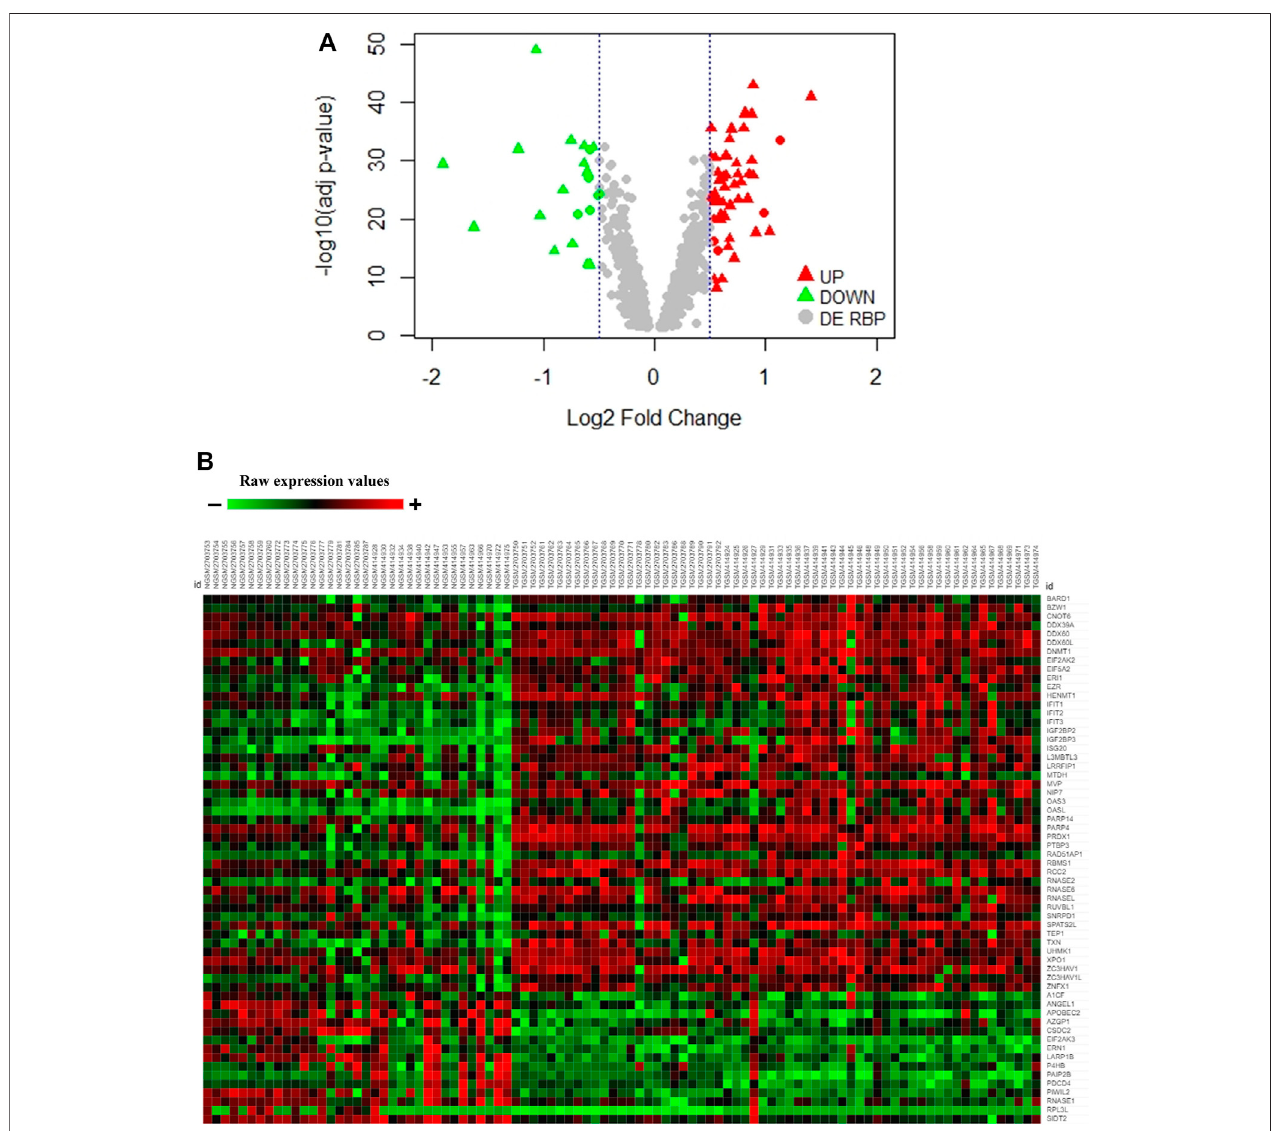
FIGURE 1 | Expression pattern of DE-RBPs in pancreatic cancer. (A) Volcano plot showing signi fi cant DE-RBPs in the discovery dataset where red and green trianglesdenotevalidatedupregulatedanddownregulatedRBPs,respectively. (B) Heatmapof60validatedDE-RBPexpressioninthetumorandnormaltissuesamples of the microarray validation dataset. Red indicates high expression and green indicates low expression.